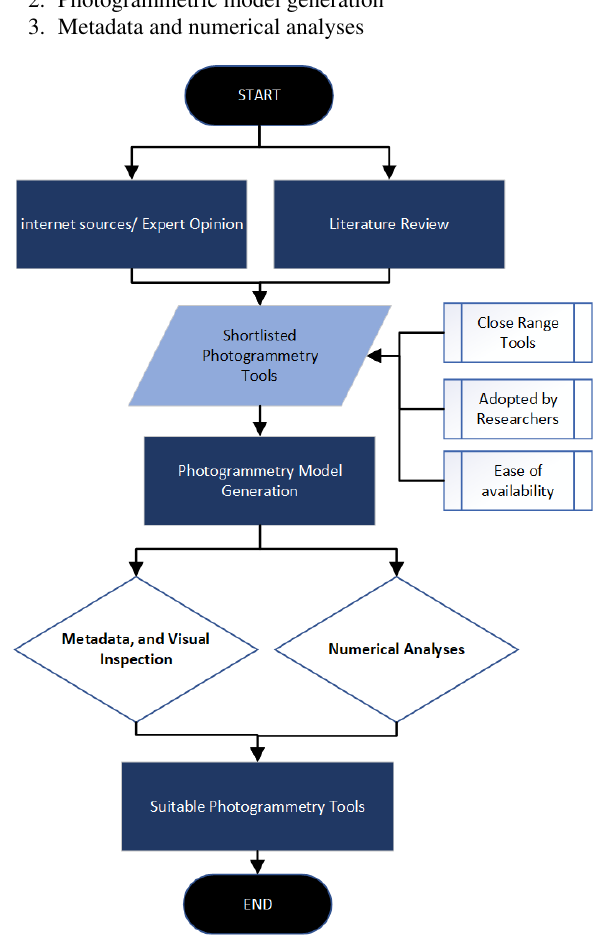
Figure 1. Study flowchart